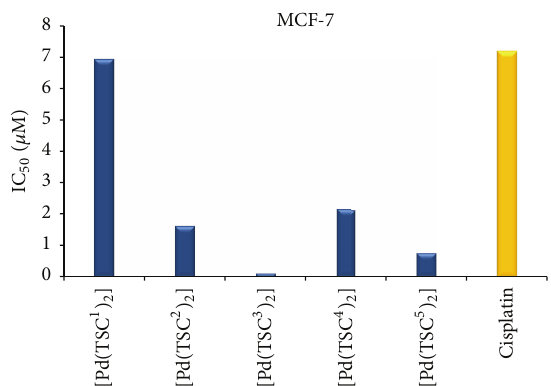
Figure 7: The antiproliferative activity in vitro expressed as IC 50 ( 𝜇 M) values of the ligands HTSC 1 – 5 , palladium(II) complexes [Pd(TSC 1 – 5 ) 2 ], and cisplatin against MCF-7 human tumor cell line after 48h incubation